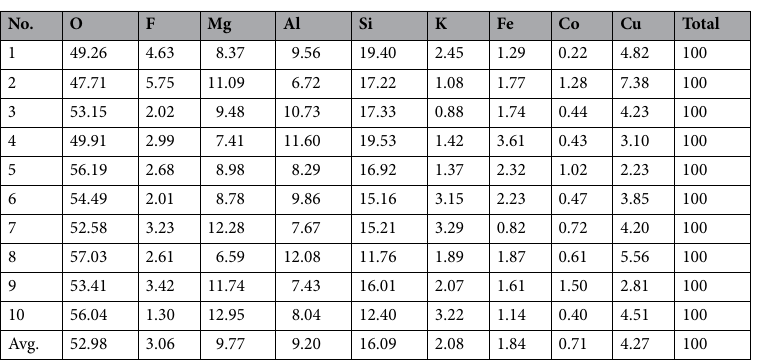
Table 2. Energy spectrum analysis data of biotite aggregations